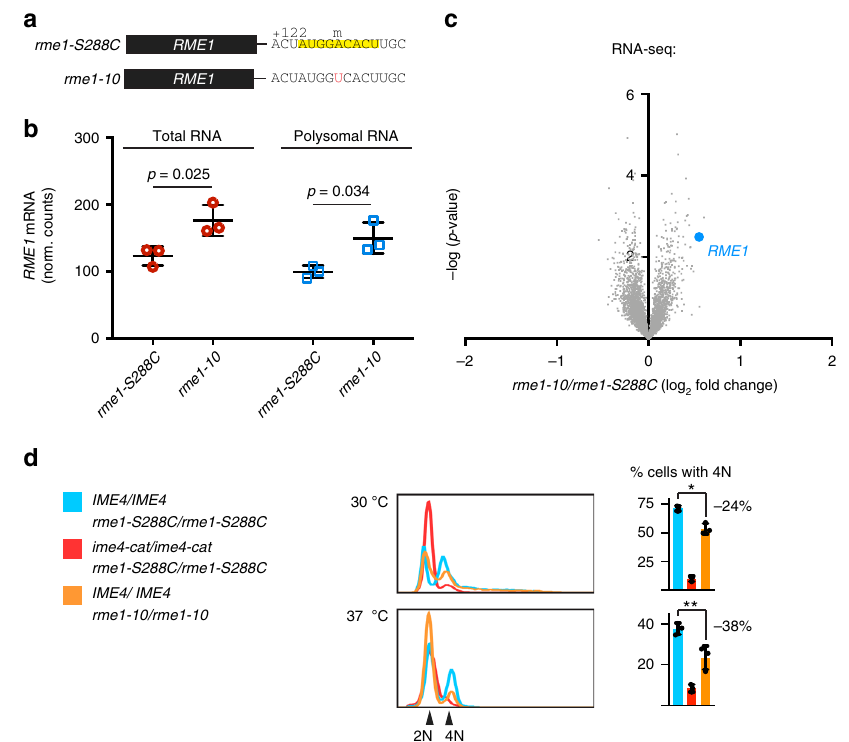
Fig. 5 RME1 methylation mutants are defective in meiotic DNA replication. a rme1-S288C and rme1-10 have the same promoter and coding sequence, but they differ in their 3 ′ untranslated region: rme1-10 has a single A to T substitution of the + 129 methylated A (marked with an m over it) in the methylation consensus motif (yellow). b RNA-seq quanti fi cations of RME1 mRNA. RME1 mRNA from input RNA prior to gradient fractionation (total mRNA) and polysome-associated RNA (polysomal RNA) from IME4 / IME4 rme1-S288C / rme1-S288C and IME4 / IME4 rme1-10 / rme1-10 cells incubated in SPO media for 5 h. Individual values, means, and s.d. from three biological replicates. Two-way analysis of variance p values are indicated. Because this experiment was performed together with the one shown in Fig. 2c, the results for RME1 mRNA in the IME4 background in Fig. 2c are re-plotted in this panel for the rme1- S288C background. Source data are provided in a Source Data fi le. c RNA-seq data from rme1-S288C homozygotes and rme1-10 homozygotes incubated for 5 h in SPO media. Data from three biological replicates are presented as normalized counts in rme1-10 , divided by normalized counts in rme1-S288C . d Flow cytometric analysis of DNA content over a meiotic time course in IME4 / IME4 rme1-10 / rme1-10 compared to IME4 / IME4 rme1-S288C / rme1-S288C and ime4-cat / ime4-cat rme1-S288C / rme1-S288C . Cells were incubated for 24 h at 30 °C or 37 °C, as indicated. Means, individual values, and s.d. from three biological replicates. * p = 0.011, ** p = 0.034, two-tailed t test. Source data are provided in a Source Data fi